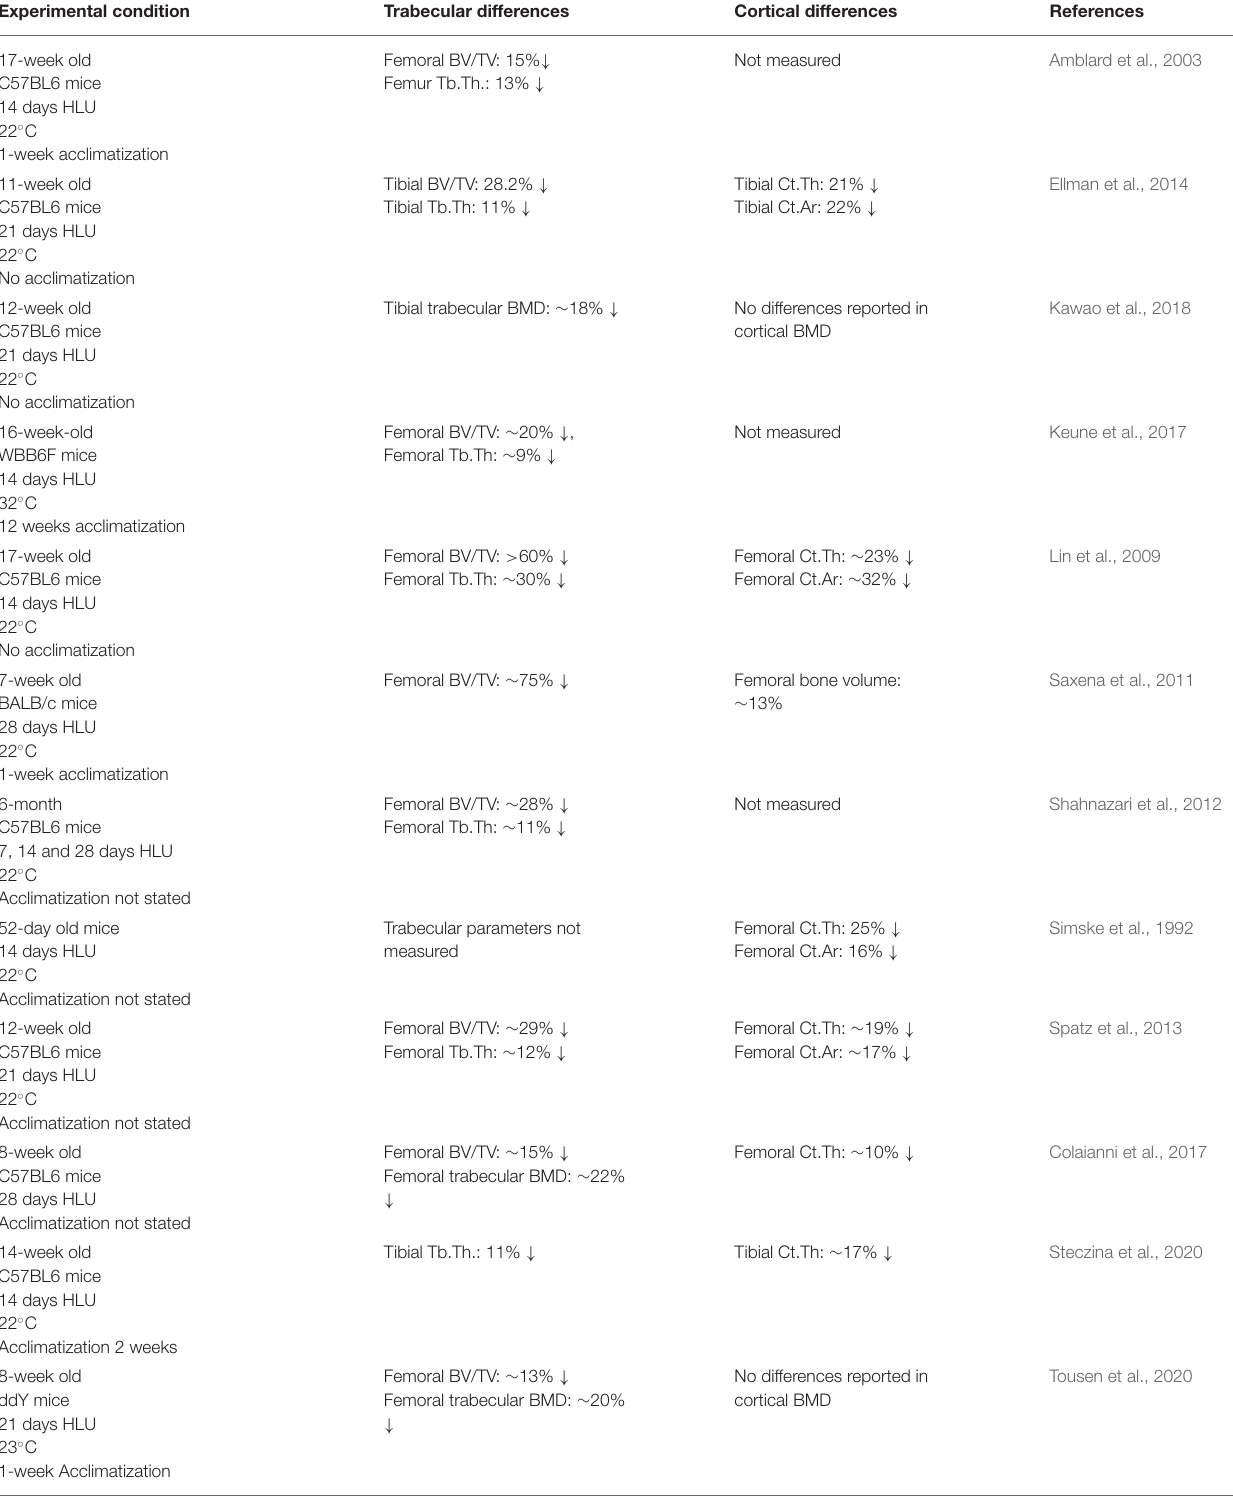
TABLE 1 | Summary of trabecular and cortical changes in mice in